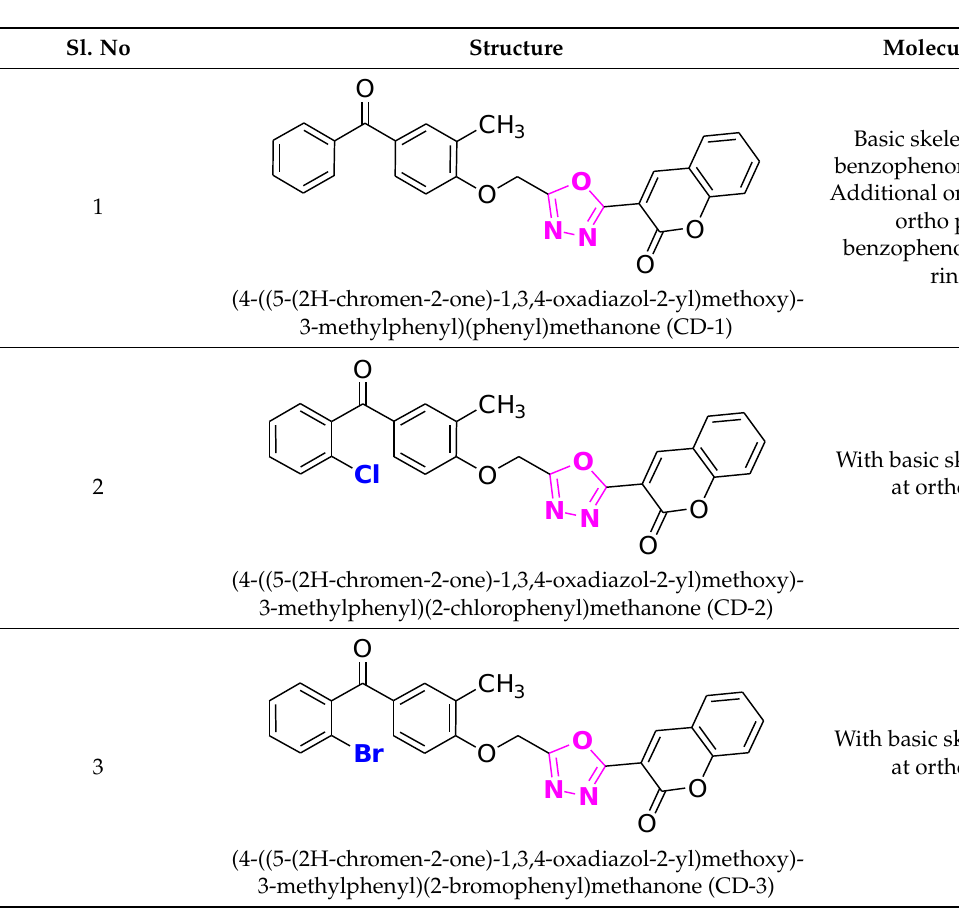
Table 1. Structural details of coumarin derivatives used in the study.